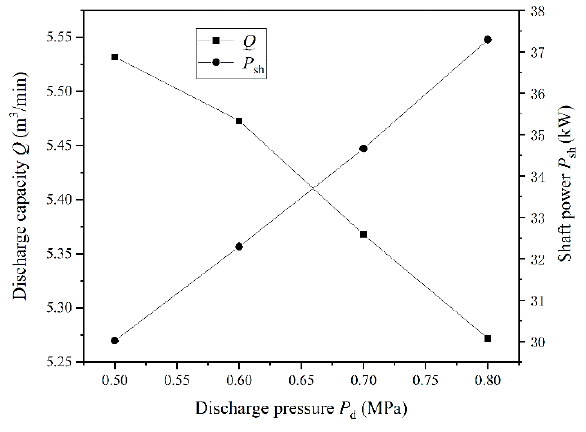
Figure 14. The compressor performance under different discharge pressures.